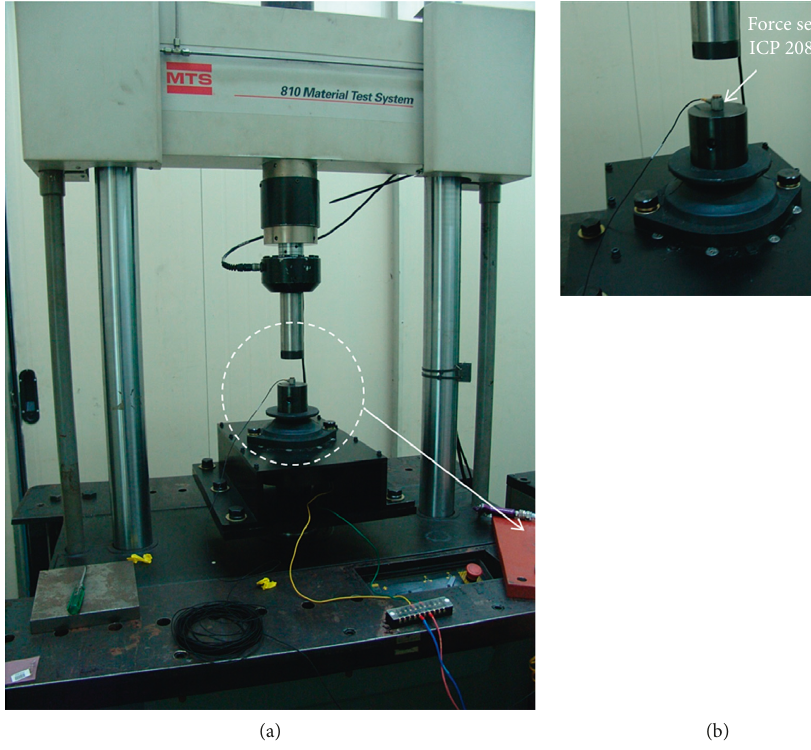
Figure 12: Experimental setup for blocking force measurement.